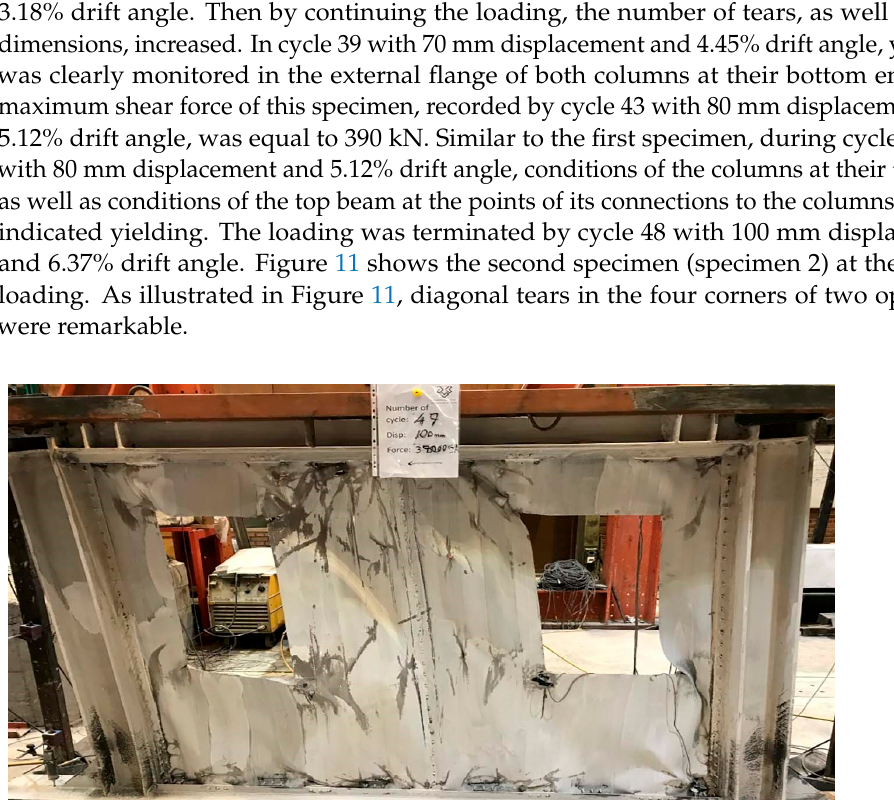
Figure 10. Specimen 1 at the end of loading.